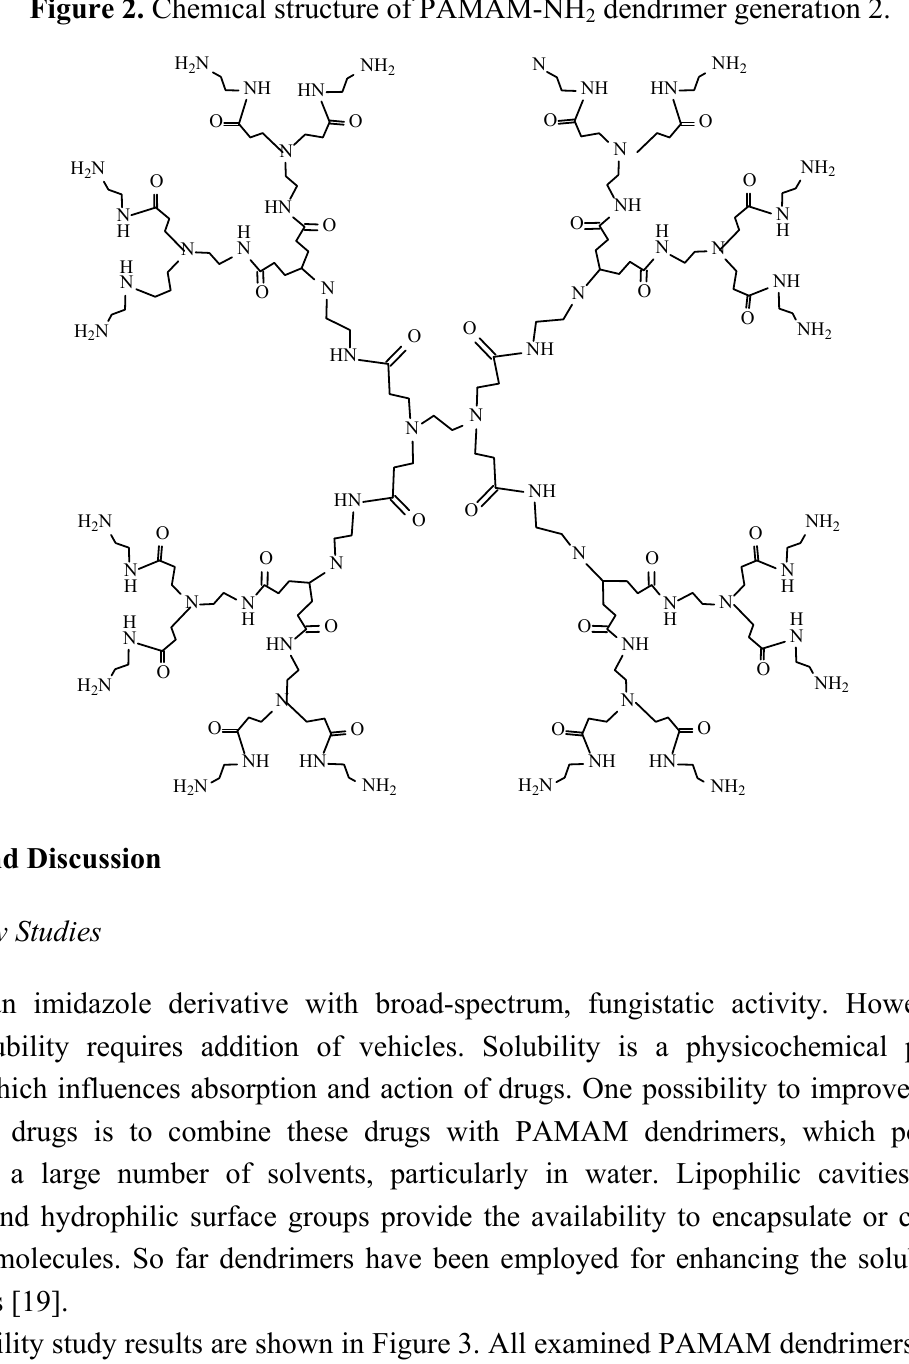
Figure 2. Chemical structure of PAMAM-NH